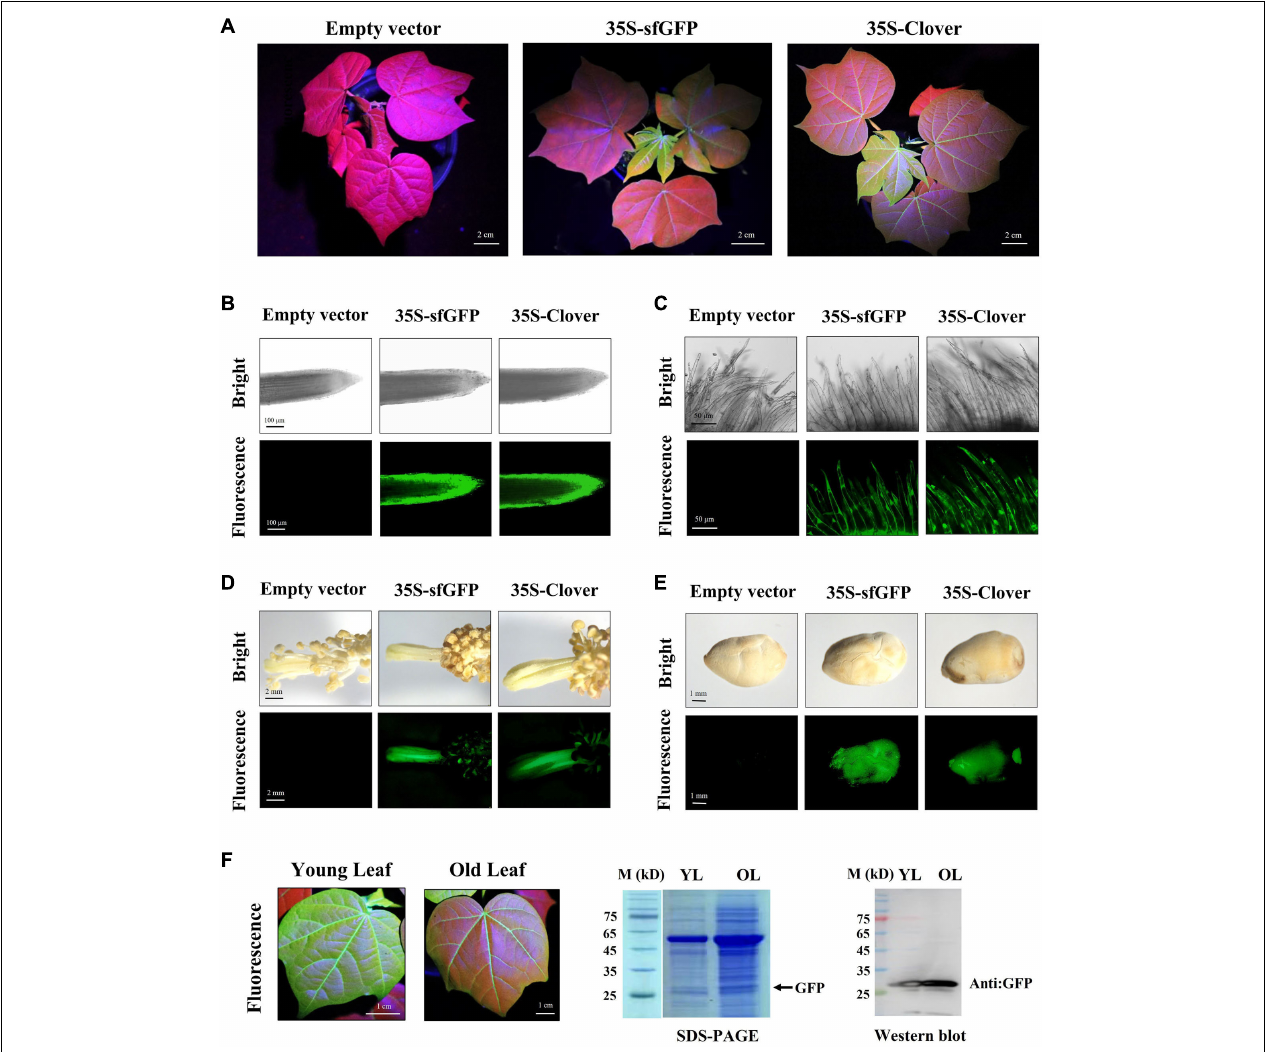
FIGURE 3 | Green fluorescent protein (GFP) fluorescence in different tissues/organs of transgenic regenerated T 0 plants. (A) Observation of green fluorescence under excitation spectra in aerial parts of transgenic cotton plants during vegetative growth stage; scale bar, 2 cm. (B–E) The root, fiber, stamen/pistil, and seed tissues of transgenic regenerated cotton plants under white light (bright) and excitation light (fluorescence). Scale bars (white) are defined in images. (F) Measurement of GFP in young and old leaf of transgenic cotton expressing Clover by western blot.